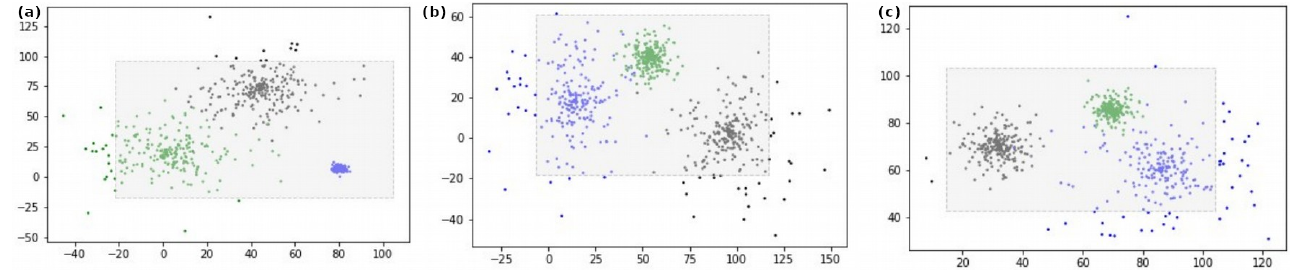
Figure 16. Synthetic test data generated for the insurance use case. ( a ) two widely spread and one very dense cluster; ( b ) three widely spread clusters; ( c ) one dense, one moderately spread, and one widely spread